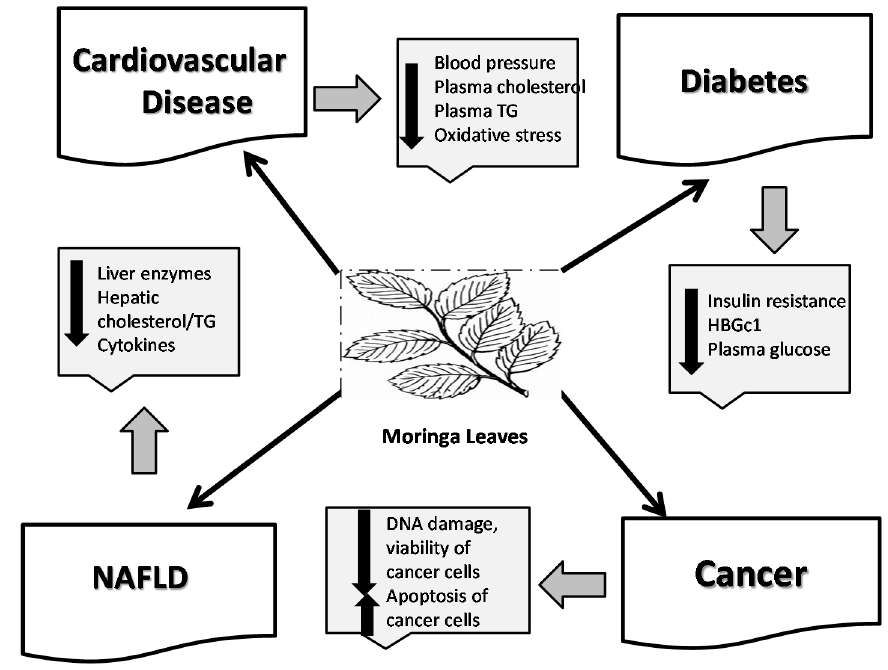
Figure 1. Protective effects of MO leaves against chronic diseases: cardiovascular disease , by lowering plasma lipids including triglycerides (TG) [45,60] decreasing blood pressure [92] and reducing oxidative stress [73]; diabetes , by lowering plasma glucose [61], reducing insulin resistance [89] and increasing β cell function [90]; NAFLD , by reducing hepatic lipids [82,87], reducing liver enzymes [82,83,88] and decreasing hepatic inflammation [88] and cancer , by reducing DNA damage [97], viability of cancer cells [99,100] and increasing apoptosis [104,105].